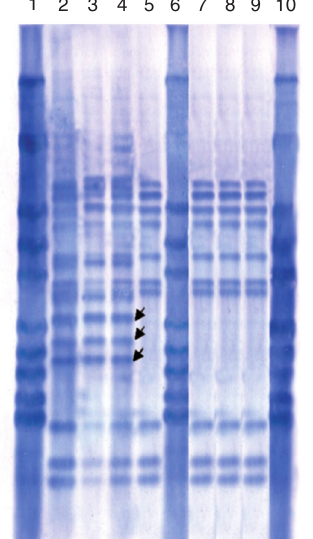
1 2 3 4 5 6 7 8 9 10